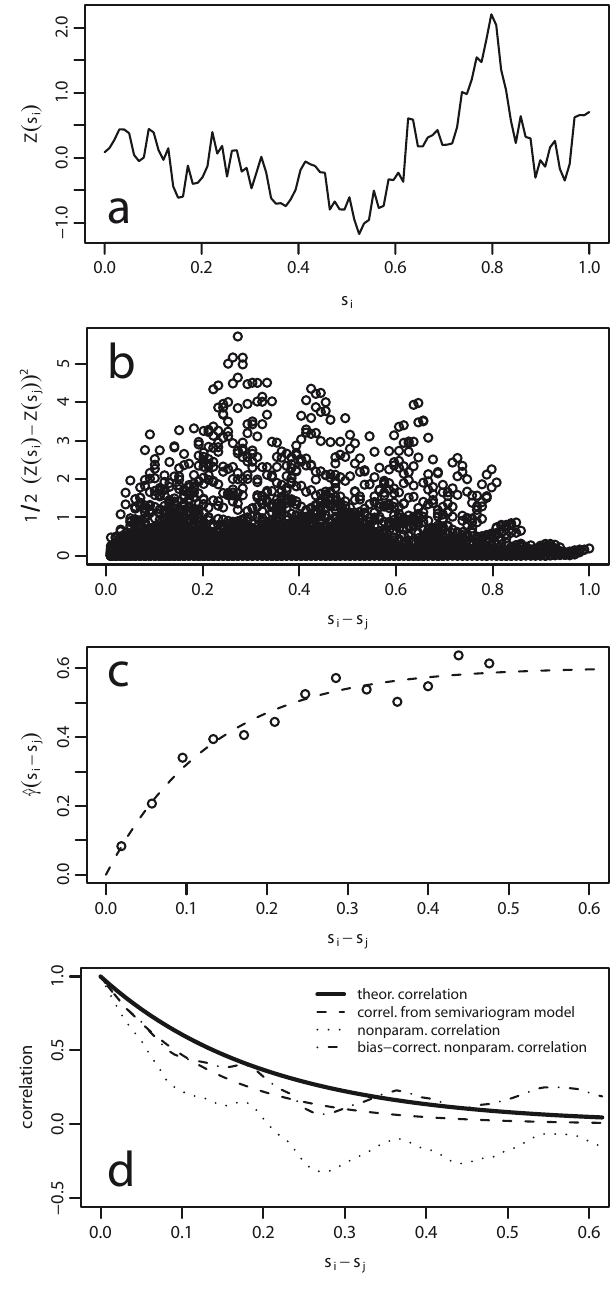
Fig. 1. Semivariogram and correlogram estimation. (a) One-dimensional synthetic data sample, (b) semivariogram cloud, (c) empirical semivariogram and fitted parametric model, (d) theoretical and estimated correlograms.